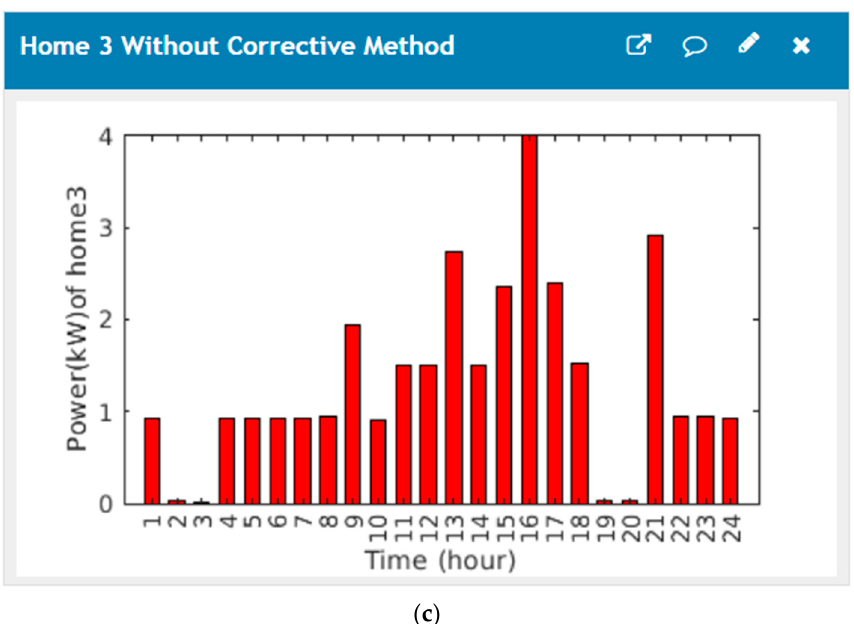
Figure 8. Power GUI of the suggested home structure without corrective method: ( a ) load profiles of the first house; ( b ) load profiles of the second house; ( c ) load profiles of the third house.